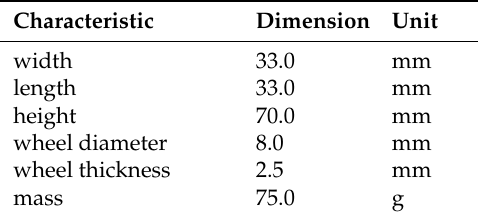
Table 1. Mechanical characteristics of